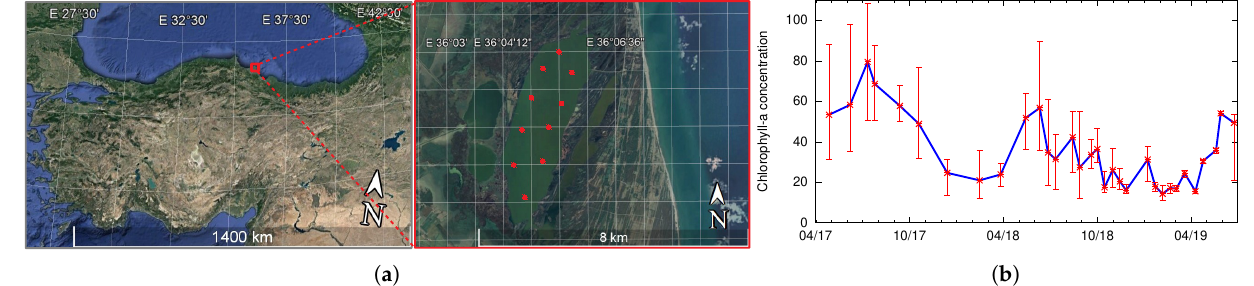
Figure 1. ( a ) The study area in North Turkey at the Kizilirmak Delta (36 ◦ 04 (cid:48) 23 (cid:48)(cid:48) N, 41 ◦ 34 (cid:48) 11 (cid:48)(cid:48) E); red dots denote measurement positions. ( b ) The Chl-a concentration distribution of our dataset across time. Each point in the plot denotes the average of 10 measurement sites, while the vertical bar represents the value range across locations; mean = 35.82 µ g/L, standard deviation = 19.43 µ g/L, minimum = 11.04 µ g/L, and maximum = 108.35 µ g/L.